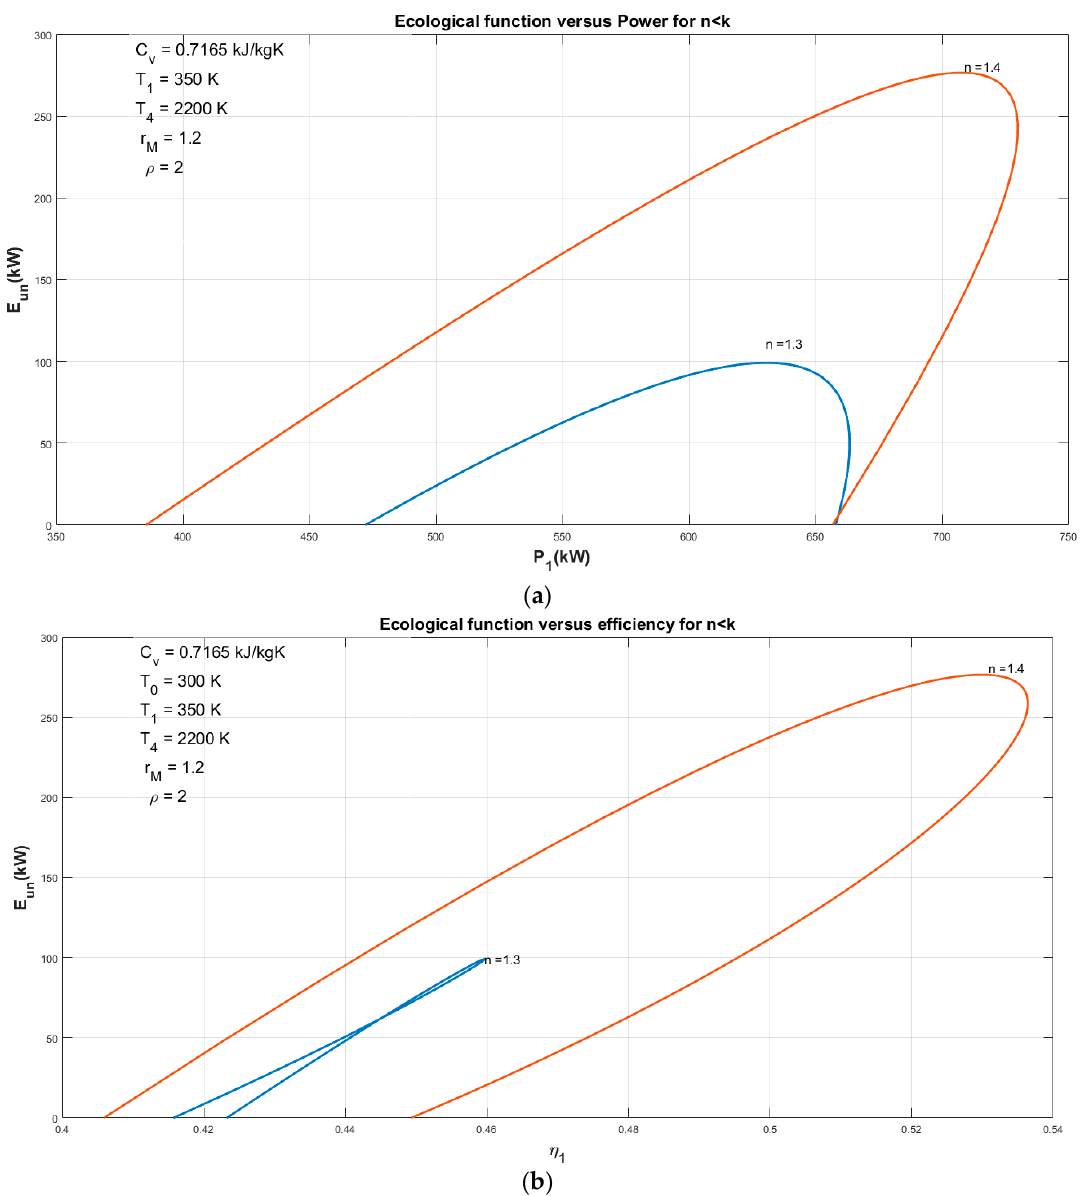
η 1 ( a ) and E un – 1 ( b